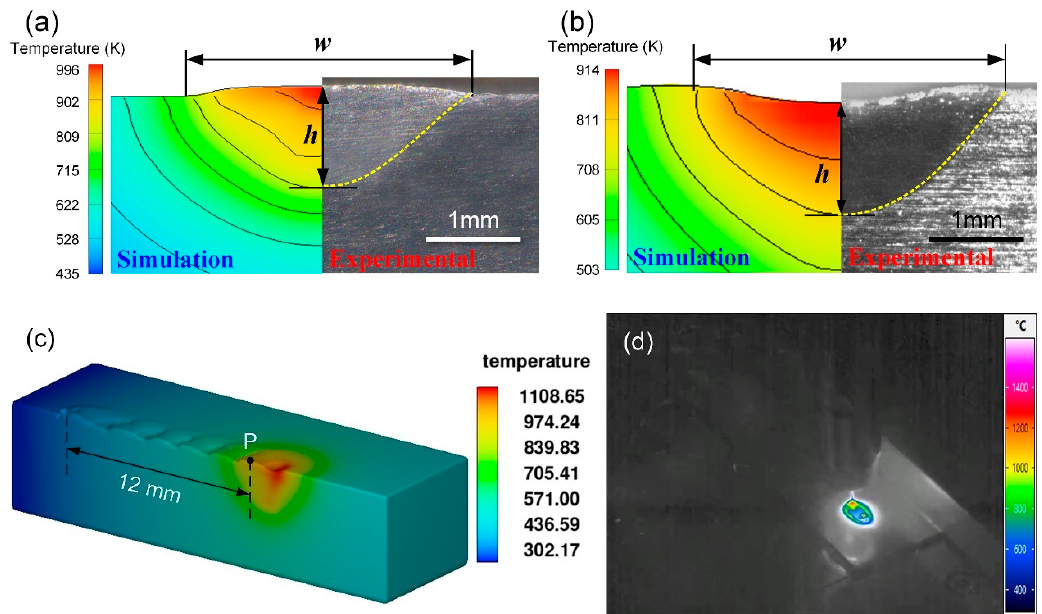
Figure 5. Comparison between the computed thermal profiles ( a ) and experimentally determined ( b ) cross-sections of the C–C and D–D section planes in Figure 4a. ( c ) Calculated weld bead profile and temperature distribution, and ( d ) measured surface temperature distribution of the weld pool using an infrared camera.